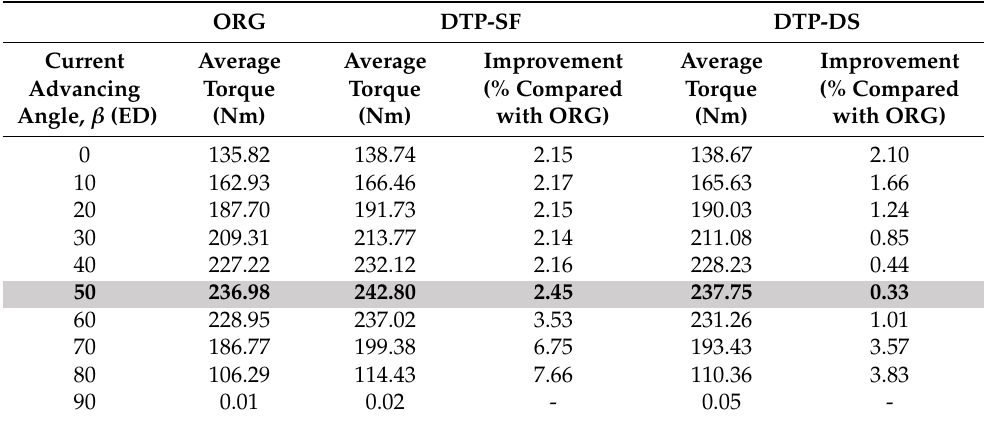
Figure 19. Average torque-current advancing angle characteristics of different winding configurations. Table 5. Comparison of average torque-current advancing angle characteristics of different winding configurations.